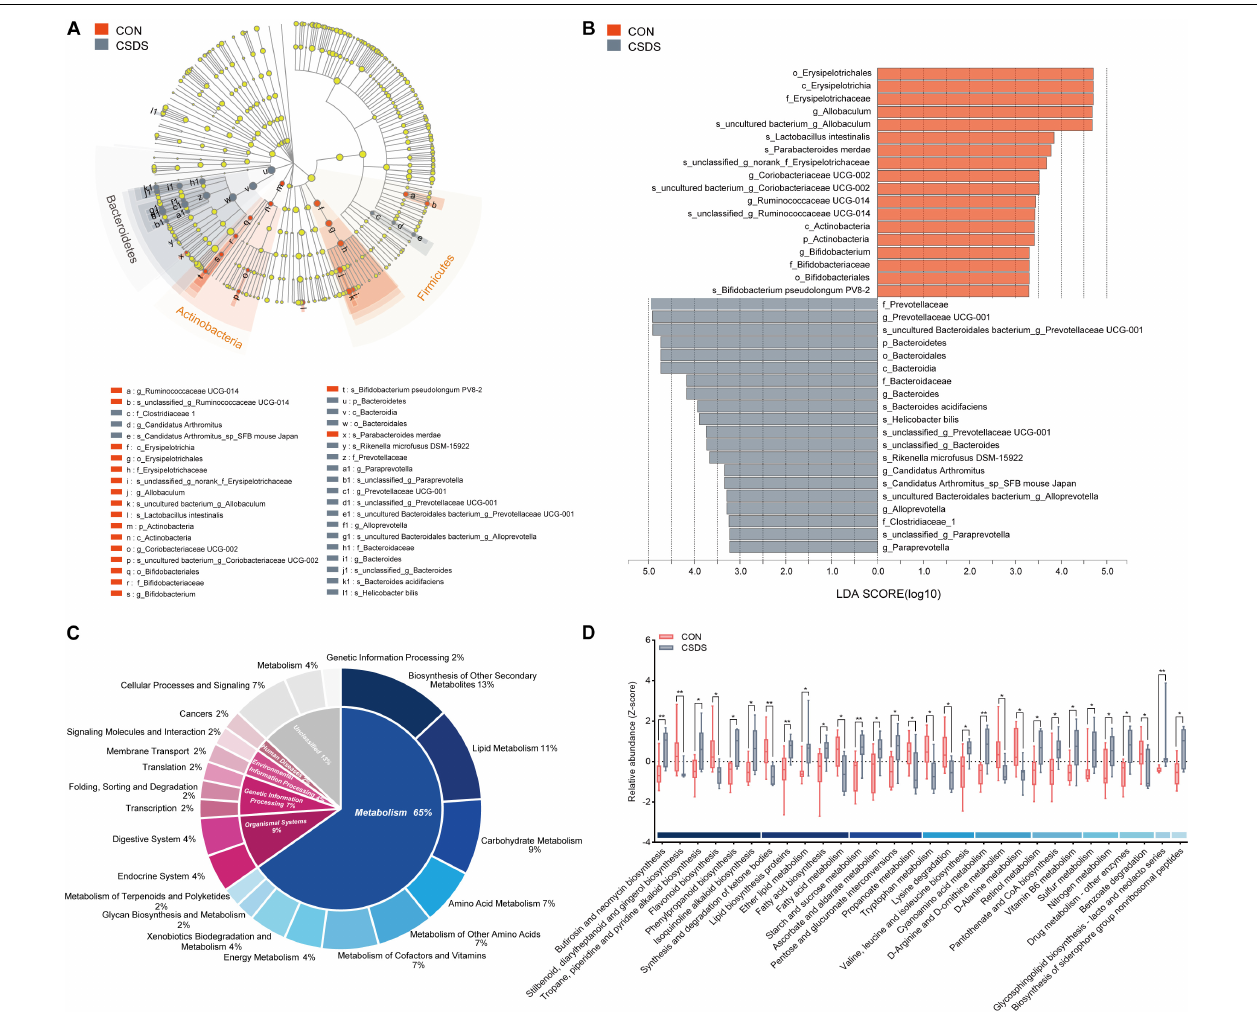
FIGURE 2 | Comparison of the gut microbiota composition and functional predictions of the altered gut microbiota between the control and CSDS mice. (A) Phylogenetic diagram of LEfSe analysis illustrated the differential gut microbiota composition between the control and CSDS mice from the phylum to species levels. At the phylum level, Bacteroidetes were significantly enriched in the CSDS mice, whereas Actinobacteria and Firmicutes were enriched in the control mice. (B) Histogram of LDA scores computed by LEfSe analysis revealed the most differentially abundant bacteria taxa in the control and CSDS mice belonged to order Erysipelotrichales and family Prevotellaceae, respectively. (C) PICRUSt functional prediction of the altered gut microbiota indicated that the metabolism category ranked the top, with a proportion of 65%. In the metabolism category, lipid metabolism, carbohydrate metabolism, and amino acid metabolism counted for 11%, 9%, and 7%, respectively. (D) Histogram of all the significantly dysregulated metabolic pathways in the metabolism category. Mann–Whitney U test, * p < 0.05, ** p < 0.01. CON, mice in the control group; CSDS, mice in the CSDS